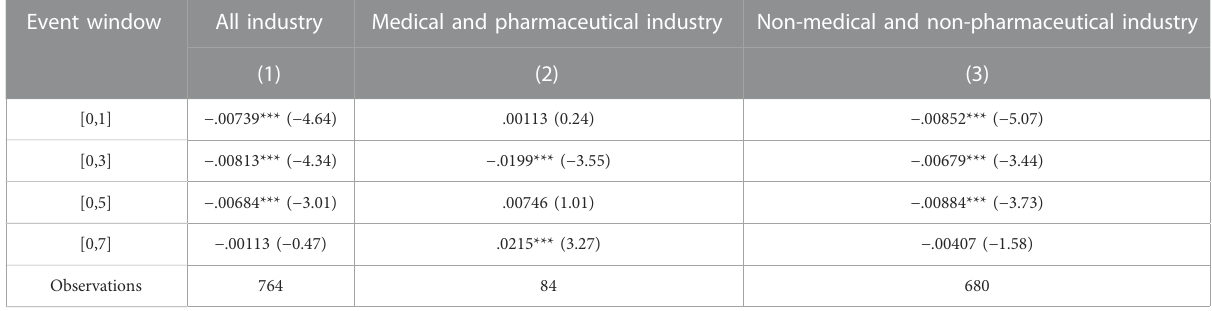
TABLE 4 The GEM ’ s respond to “ Rate Cut ”